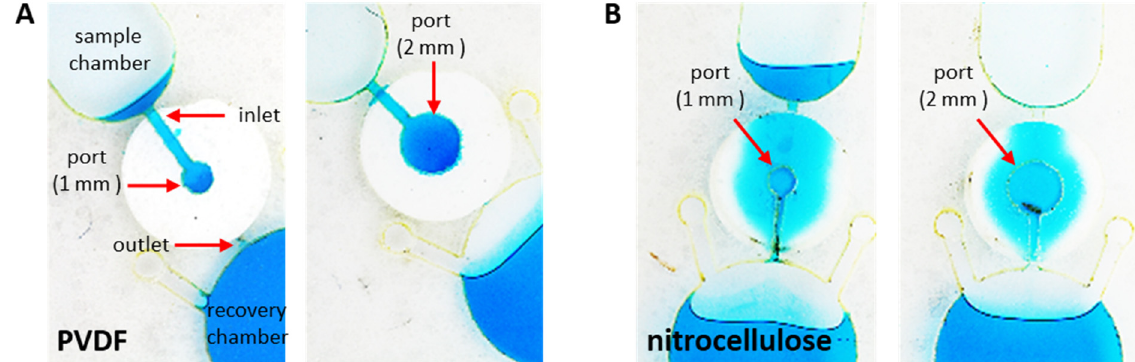
Figure 2. Proof-of-principle dye studies to demonstrate feasibility of disc-based orthogonal flow through porous membranes. Small aliquots (13 μ L) of erioglaucine-spiked artificial blood plasma (ABP) were added to each sample chamber to permit visualization of flow pattern through the membrane. Rotational forces were used to pump the fluid aliquots through membranes comprised of ( A ) PVDF and ( B ) nitrocellulose. Fluid intrusion and flow through began at 500 and 4000 rpm, ( A ) and ( B ), respectively. Complete flow through was observed in 30–45 s. This figure features representative AFTER images of the ( A ) PVDF and ( B ) nitrocellulose membranes.